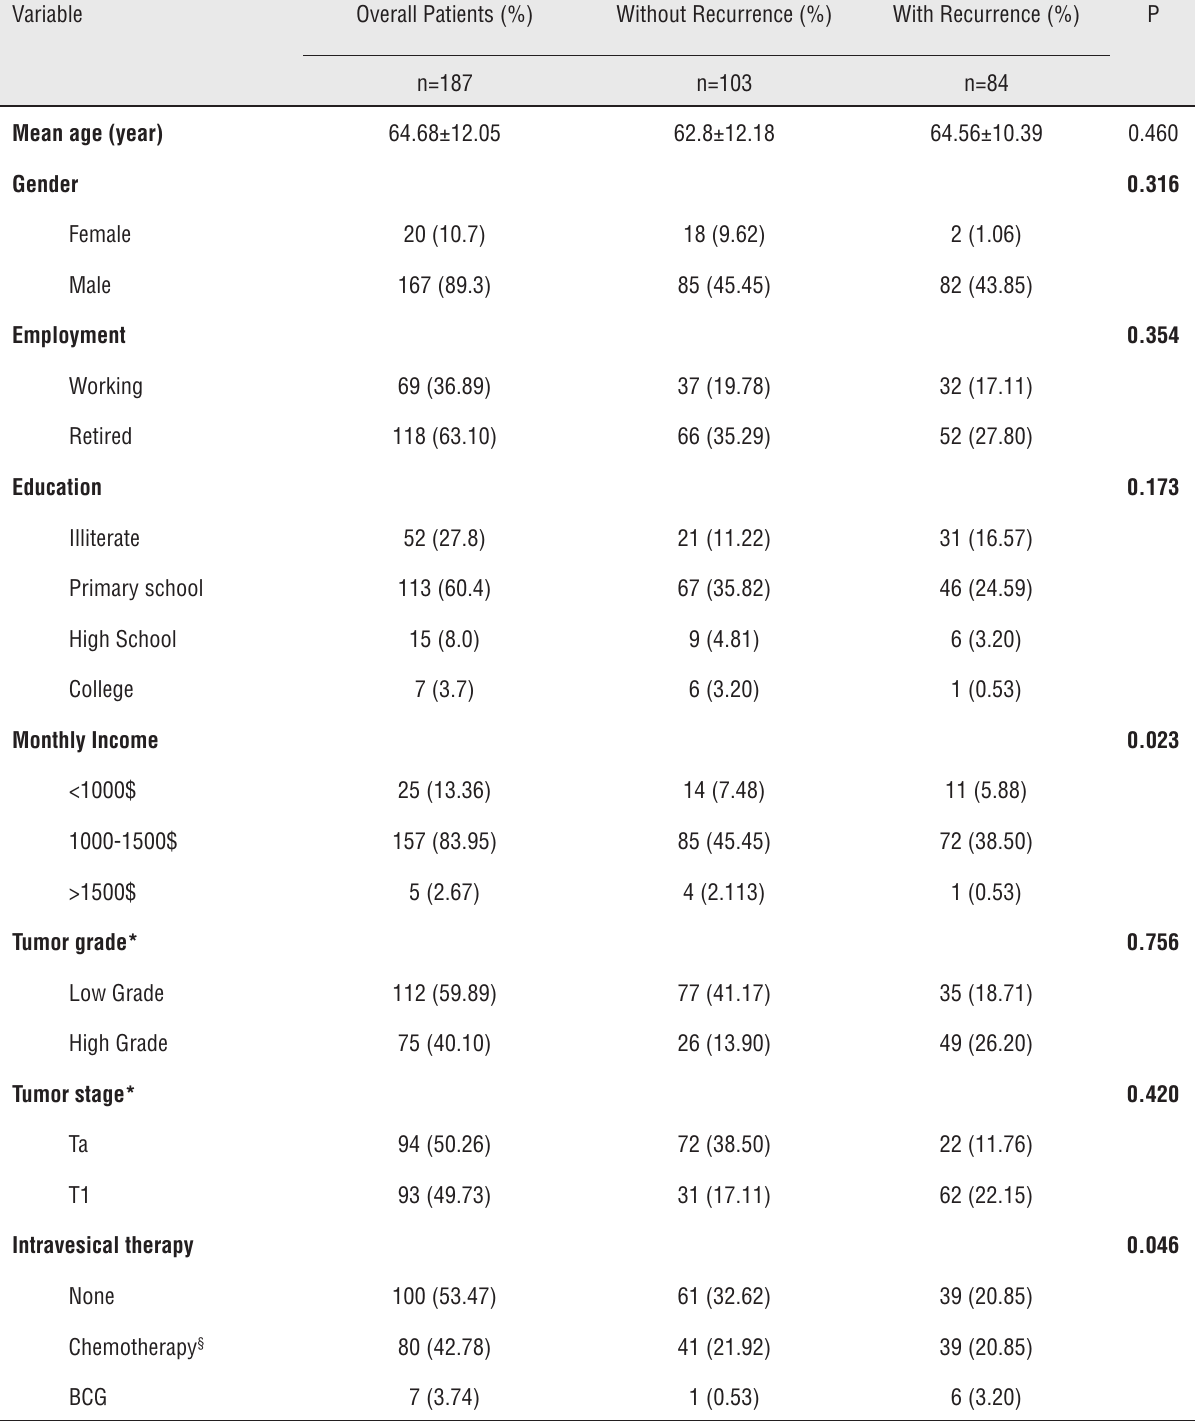
Table 1 - Demographic characteristics and course of the disease of patients who completed the survey and enrolled into the study.